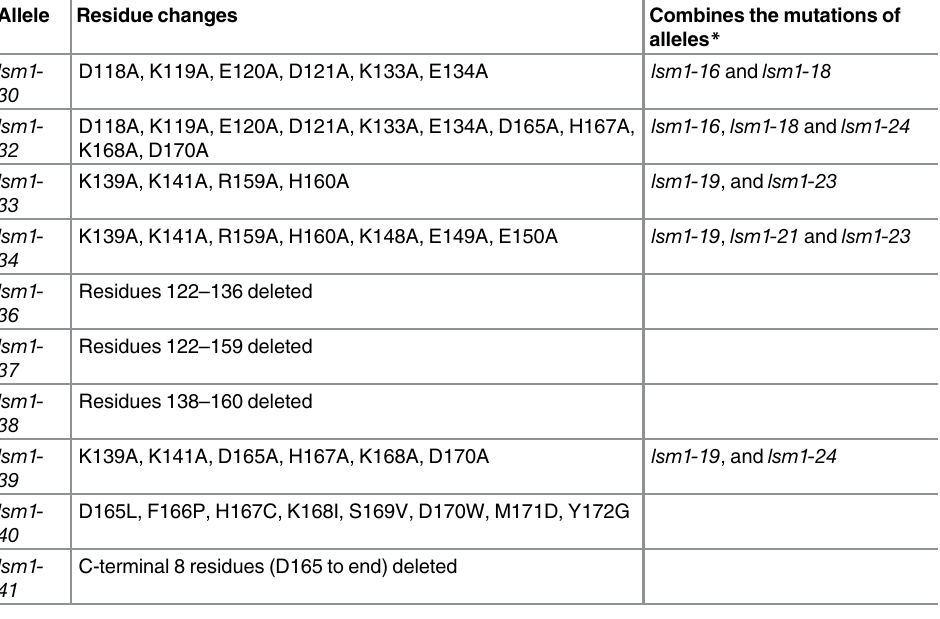
Table 2. Residue changes in the various lsm1 alleles generated in this